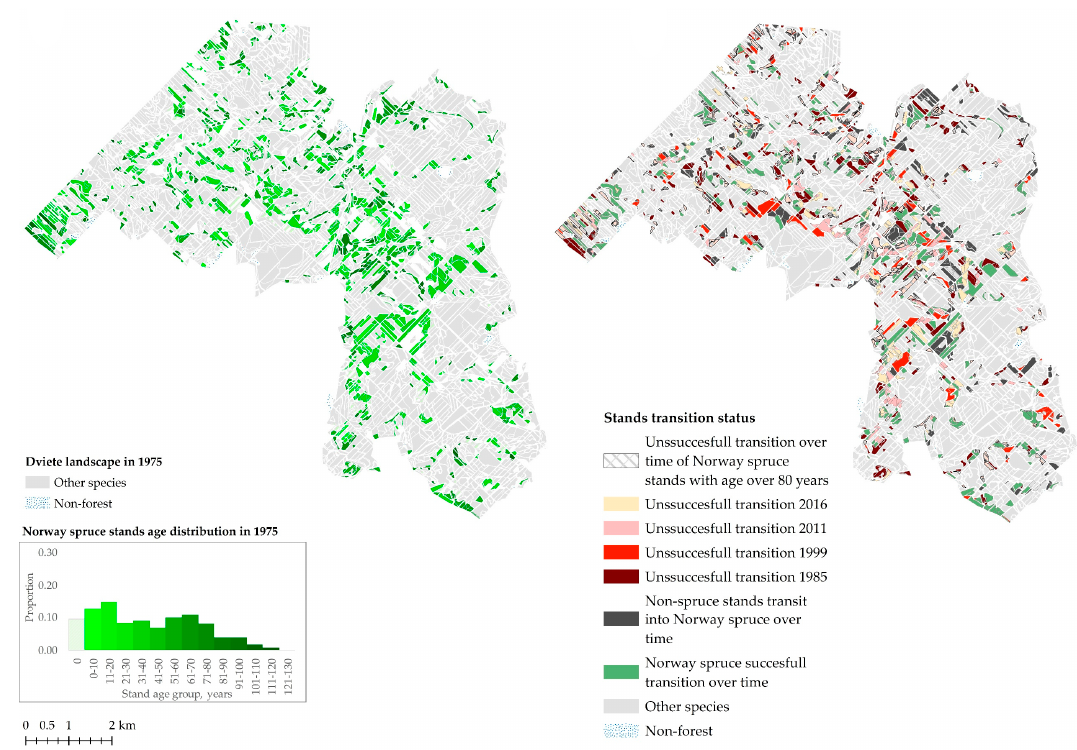
Figure 3. Norway spruce stand dynamics in Dviete over 40 years